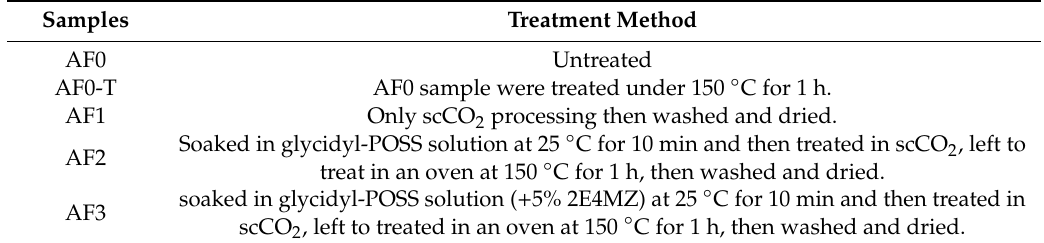
Table 1. Sample number and treatment method.